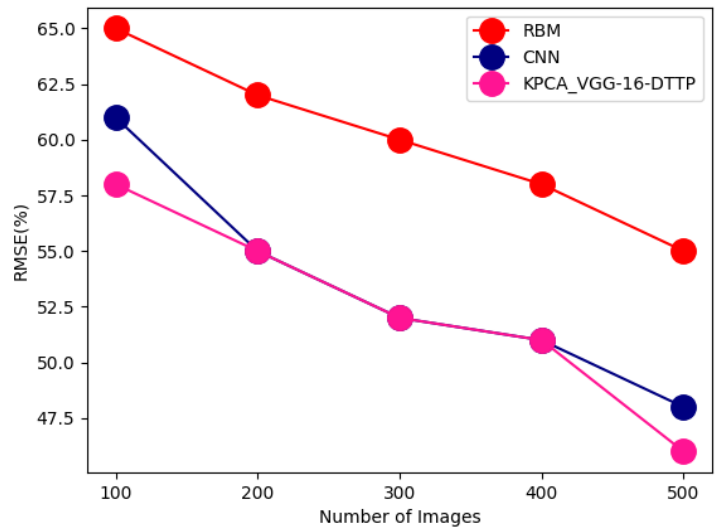
Figure 6. Comparison of RMSE.